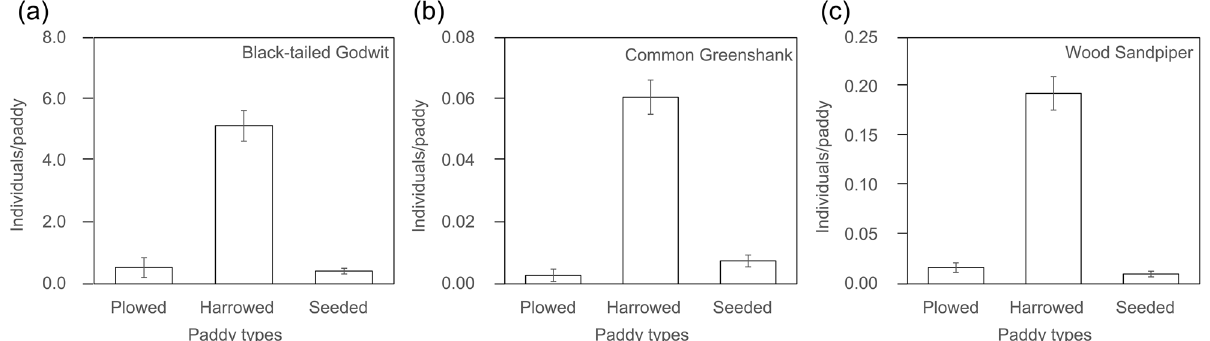
Figure 2. Barplots with error bars showing the mean density (individuals/paddy) of shorebird species in different types of rice fields. The total number of samples from plowed, harrowed, and seeded field types for the survey periods were 2,197, 6,083, and 5,380, respectively. Error bars indicate the standard error: ( a ) Black-tailed Godwit; ( b ) Common Greenshank; ( c ) Wood